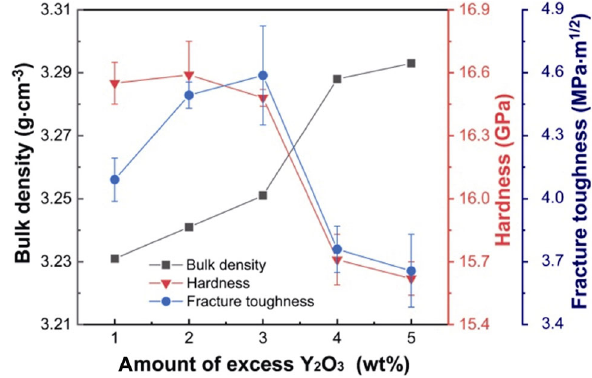
Fig. 10 Bulk density, hardness, and fracture toughness variations with the change in the the amount of excess Y 2 O 3 .